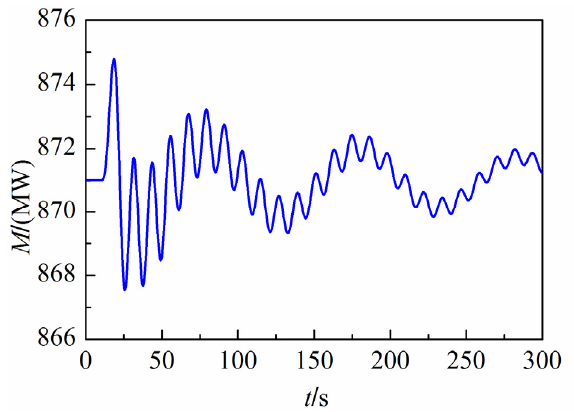
Figure 40. Output traces of turbine #5 for Case